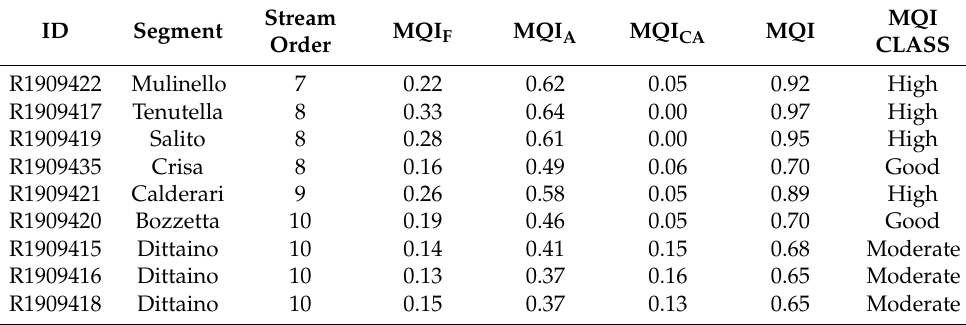
Figure 8. Statistic distributions (1st, 2nd,and 3rd quartiles) as well as minimum and maximum values of functionality MQI (MQI F ), artificiality MQI (MQI A ), channel adjustment MQI (MQI CA ), and MQI for each reach of the same order identified in the Dittaino River. Table 7. Median values of functionality MQI (MQI F ), artificiality MQI (MQI A ), channel adjustment MQI (MQI CA ) and MQI for each segment identified in the Dittaino River.